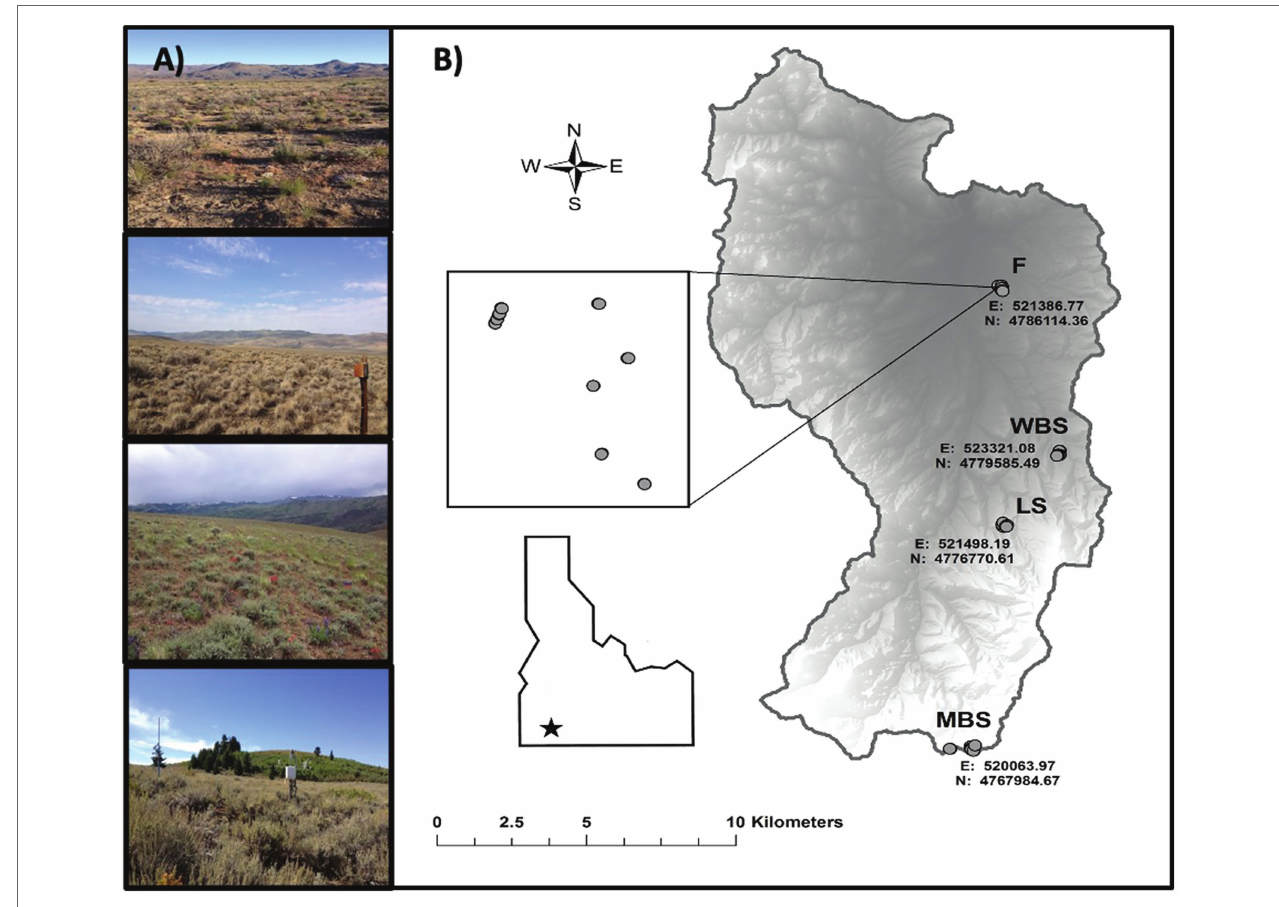
FIGURE 1 | Summary maps for the Reynolds Creek Critical Zone Observatory (RC CZO) in southwest Idaho, United States. (A) Photographs of the four main study sites [top to bottom, from lowest to highest elevation, these are F (1,170 m), WBS (1,400 m), LS (1,600 m), and MBS (2080 m)] and sagebrush vegetation. (B) Maps showing elevation, and other geographic